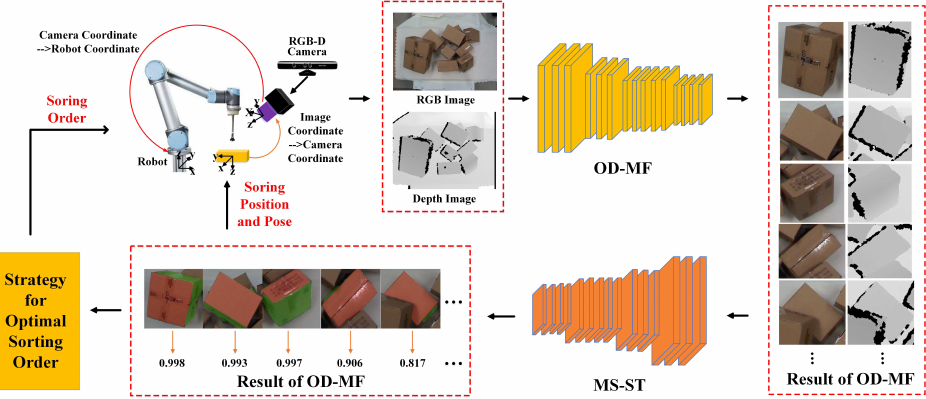
Figure 1. The overall framework of VS-MF consisting of OD-MF, MS-ST, a strategy for the optimal sorting order module and a robot system.